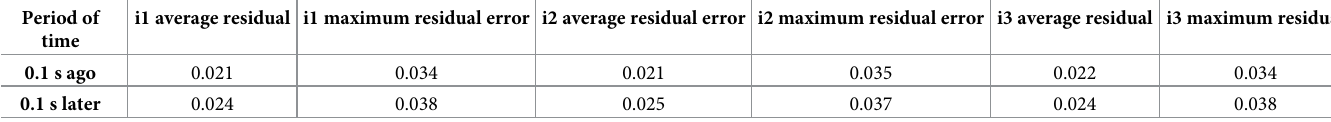
Table 10. Comparison of residual current of each sensor under the simulation of simultaneous occurrence of multiple faults. Period of time